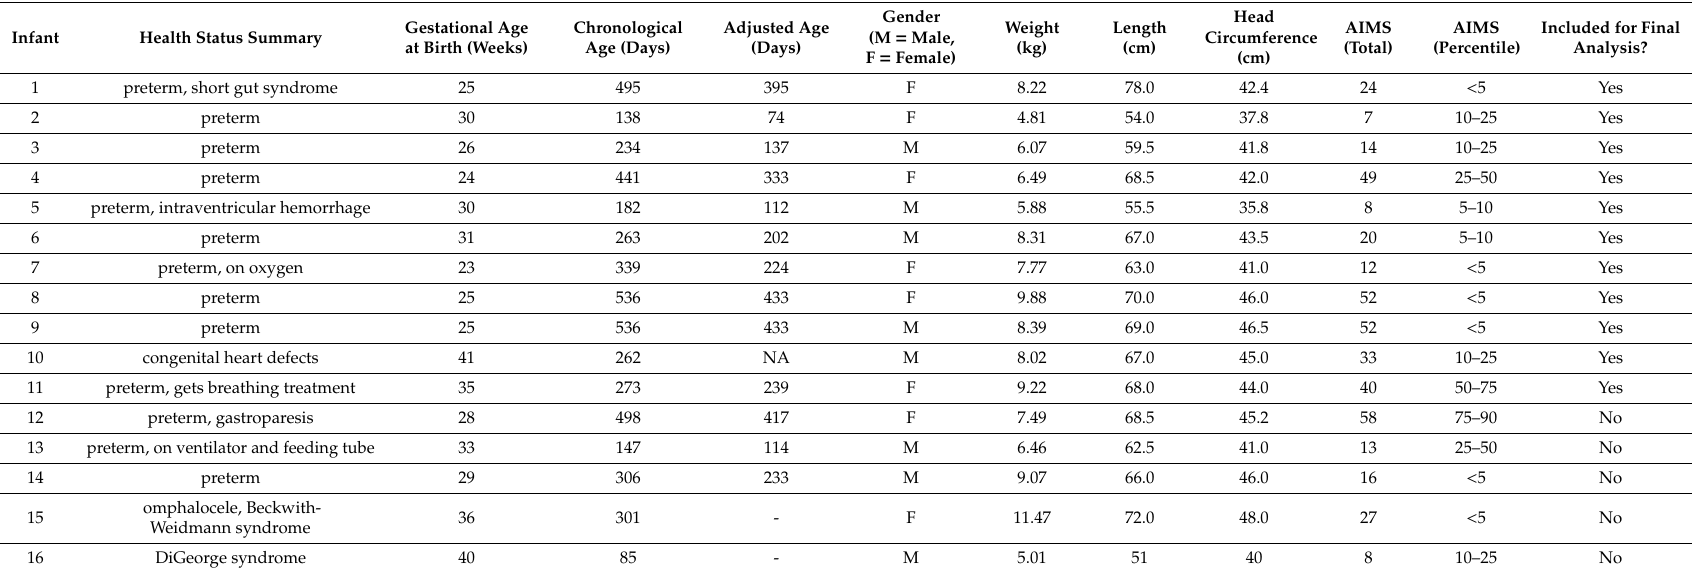
Table 1. Participant’s health status, anthropometric measurements, and motor developmental